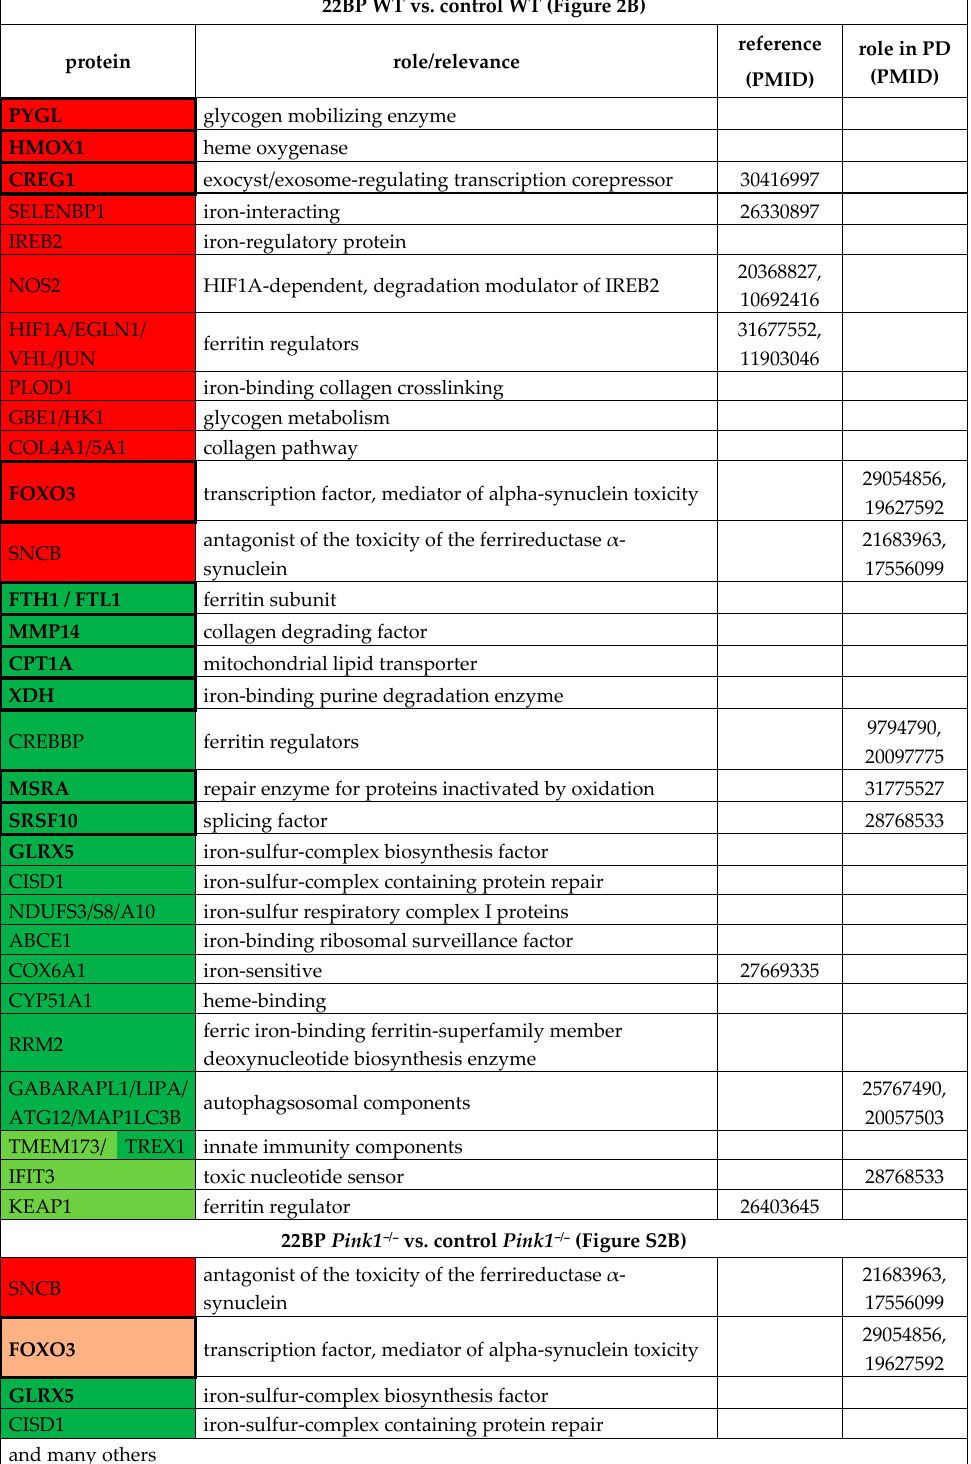
Table 2. 22BP e ff ects. Overview of selected significantly changed factors in the global proteome of MEF, comparing 22BP WT vs. control WT, and 22BP Pink1 − / − vs. control Pink1 − / − , listing their respective roles and PMIDs, and highlighting special relevance for PD. Upregulations are shown with dark red (FDR > 0.05) and light red ( p > 0.05), whereas downregulations are marked with dark green (FDR > 0.05) and light green ( p > 0.05). Factors that show converse regulations after iron overload versus iron depletion and thus appear in several tables are marked with bold fonts. Factors with dysregulations in diverse conditions are emphasized by increased table cell border thickness. For details, see Figure 2 and Supplementary Table